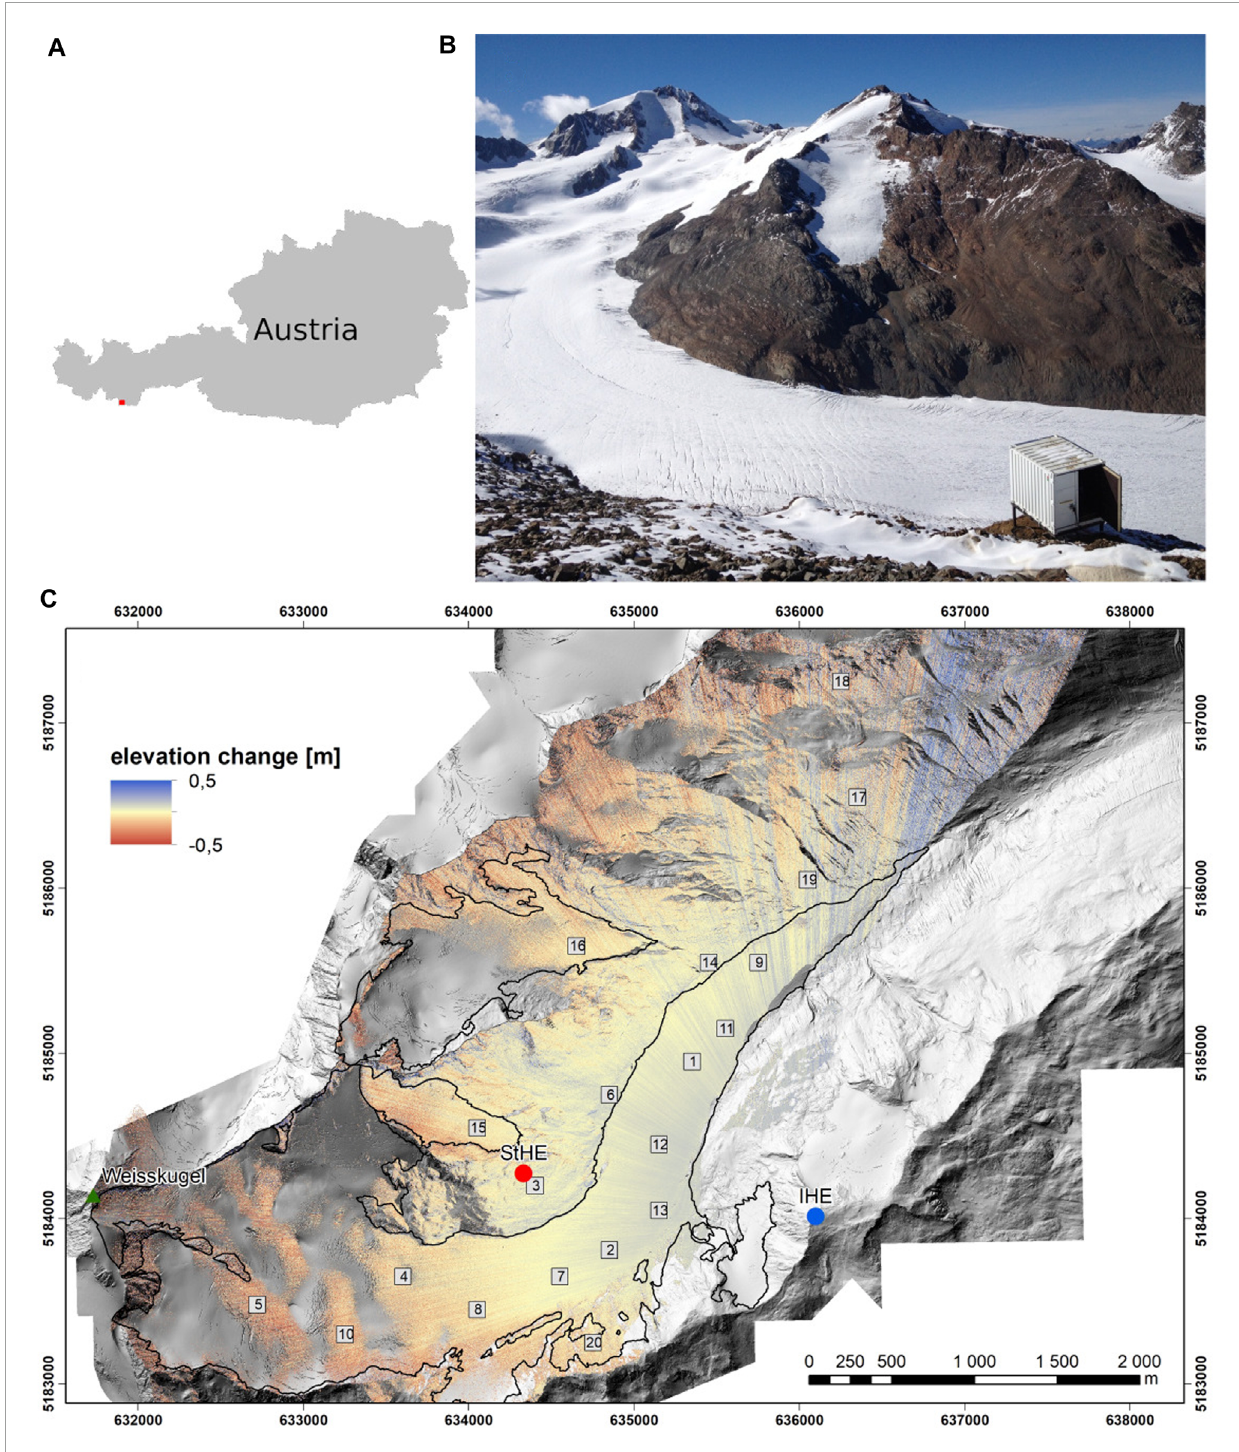
FIGURE 1 (A) Location of the Rofental (red square) in Austria. (B) TLS container overlooking HEF. Photo taken by Daniela Brugger, September 2016. (C) Differential plot after automated registration (Sect. 3.2) between 10:55 and 12:13 UTC on 5 November 2020. Twenty areas (boxes) of 100 by 100 m were selected at the glacier for detailed uncertainty analyses. The hillshade in the background and the glacier outlines are derived from the ALS data acquired by the Federal Government of Tyrol in 2018. IHE (3,245 m a.s.l.) is given as a blue dot, StHE (3,026 m a.s.l.) is the red dot, and the highest peak Weißkugel (3,739 m a.s.l.) is a green